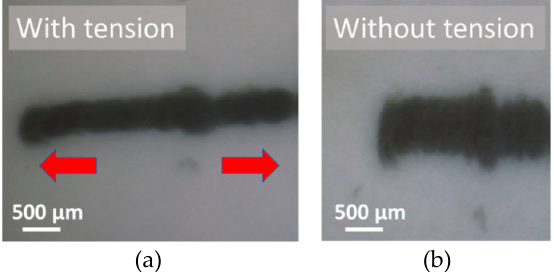
Figure 9. Result of the wiring experiment. ( a ) Magnified view of the rubber with tension and ( b ) without tension.